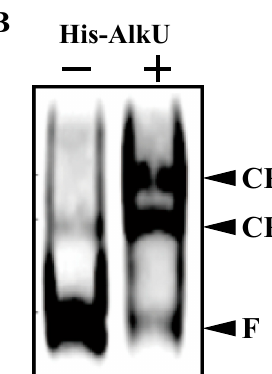
Figure 7. Binding of His-AlkU to the upstream region of alkB . ( A ) Schematic diagrams of the upstream region of alkB . Black boxes revealed the region of DNA probe used in EMSAs. Underlines indicate a putative -10 and -35 sequences. Open box indicates start codon of alkB . Putative IR sequences are shown on top of nucleotide sequences. ( B ) EMSAs of the binding of purified His-AlkU (50 ng) to the DNA probe. The positions of the free probe and His-AlkU-DNA complex are shown by F and CP, respectively. + and − indicate presence and absence of His-AlkU, respectively.